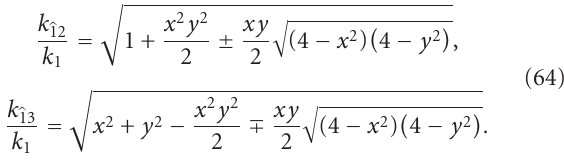
(cid:2) (cid:2) (cid:2) k 1 + k 2 + k 3 = 0 (in particular, we set x 3 < x 2 ). We also set x ∗ =